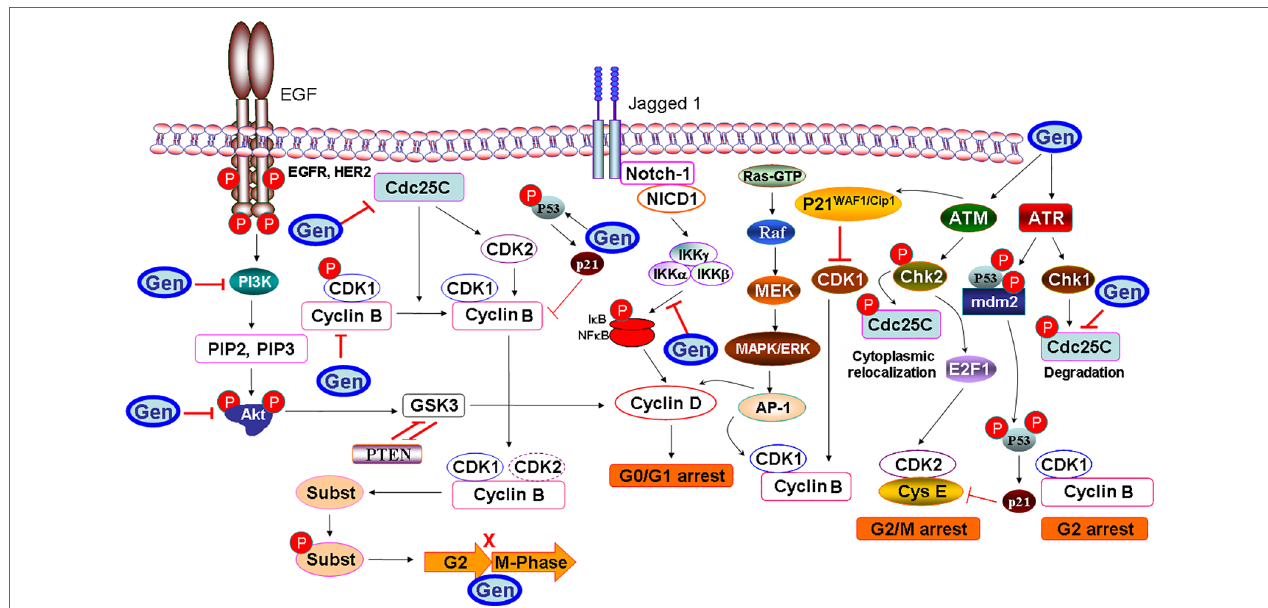
FIGURe 5 | Molecular targets of genistein (Gen) in cancer cell cycle. Although genistein activates the expression of ATM protein family and ATM-related (ATR), and further activates the checkpoint kinases Chk2 and Chk1, which in turn phosphorylate Cdc25C. However, genistein promotes cytoplasmic relocalization and or degradation of Cdc25C, which would prevent cyclin-dependent kinase 1 (Cdk1)/cyclin B from being dephosphorylated and cause G2 arrest. ATM may also modulate transcriptional regulation of cell cycle progression through modification the expression of p53 and Mdm2, or through activation of Chk2, which can further modulate p53, E2F1 expression, leading to an upregulation in the p21 expression that would inhibit Cdk2 activity. ATM also phosphorylates the p53 tumor suppressor though the induction of Cdk inhibitor p21 Waf1/Cip1 . Genistein also could inactivate phosphatidylinositol-3-kinase (PI3K)/serine/threonine kinase (Akt)/glycogen synthase kinase 3 (GSK3) signaling pathway, whether through the prevention of the phosphorylation of Act and upregulation of the prime time entertainment network (PTEN) expression. Genistein may also mediate cell cycle arrest by suppressing NF-κB-mediated activation of cyclin D1 expression.